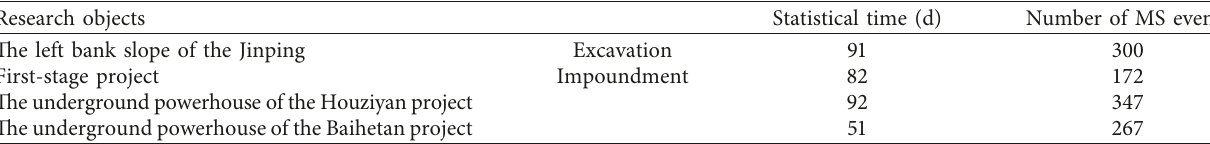
Figure 1: Results of MS signals after ST: (a) the time-domain waveform of MS signals, (b) time-frequency spectrum, and (c) time-frequency amplitude spectrum. Table 1: Statistical sample of research